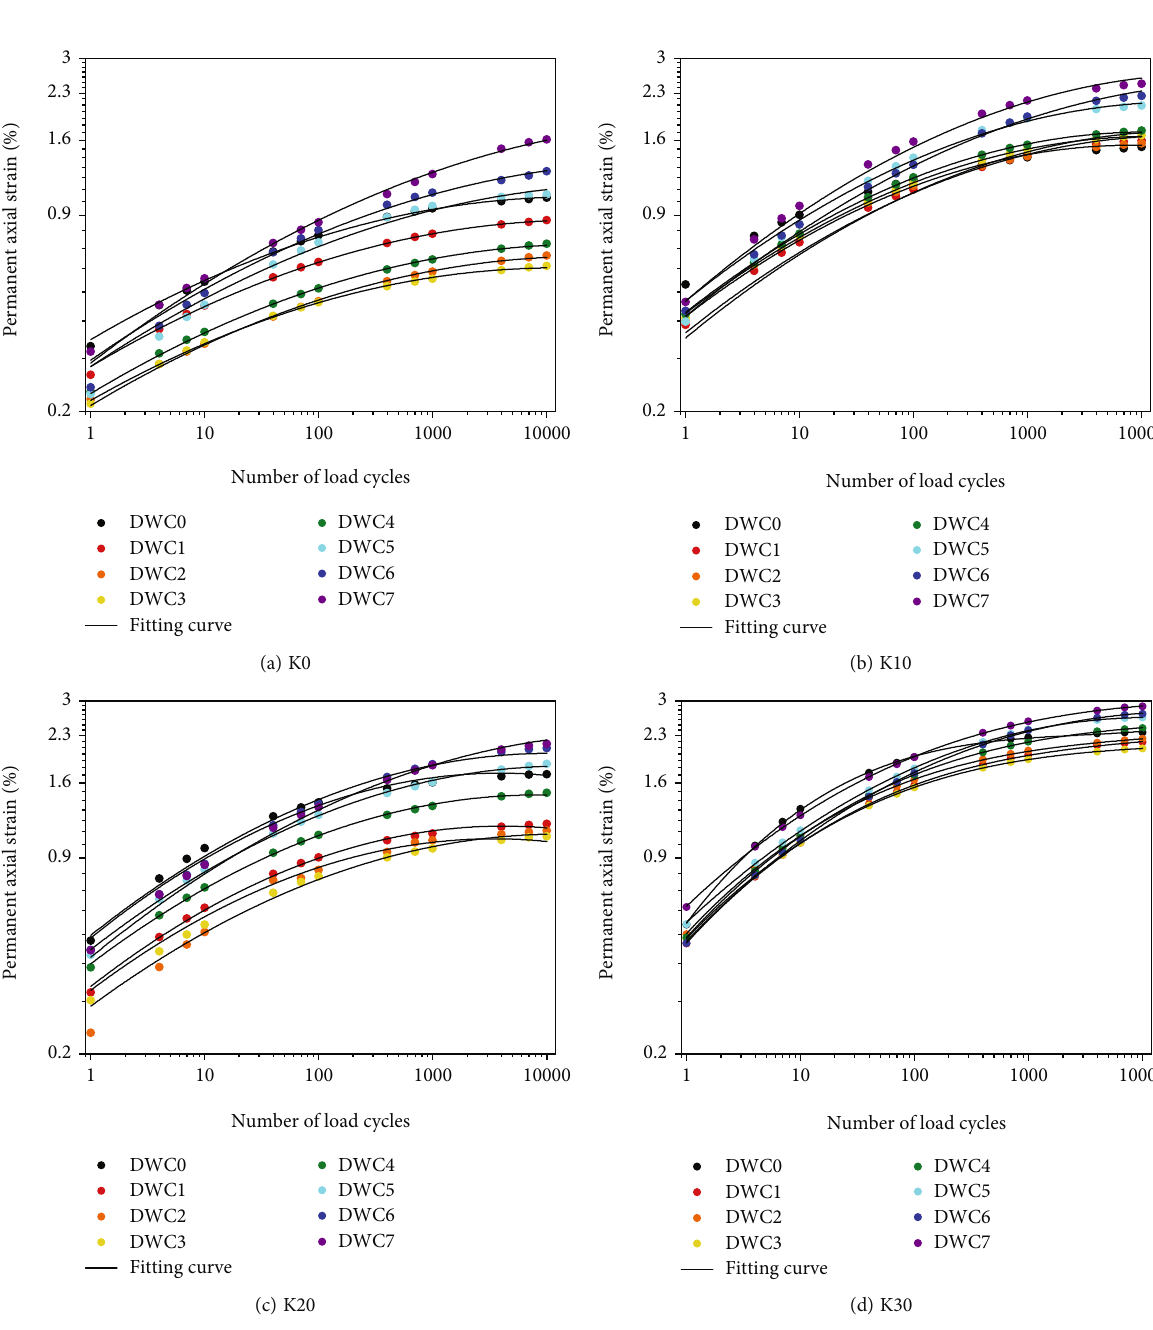
Figure 19: Permanent axial strain fi tting of